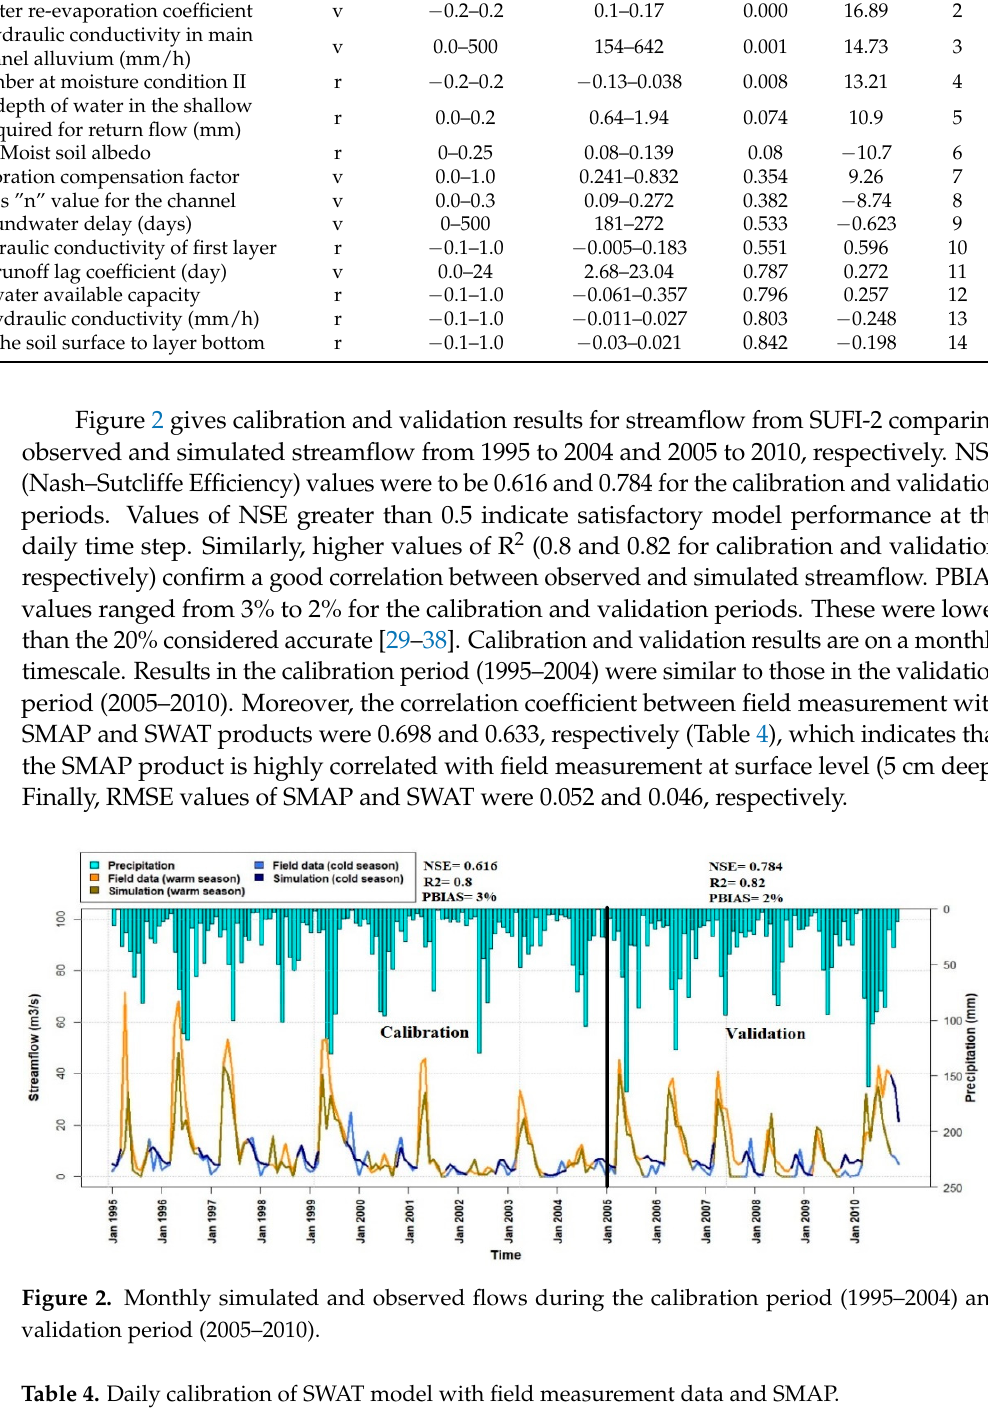
Table 3. Parameters used for calibration with optimum values.